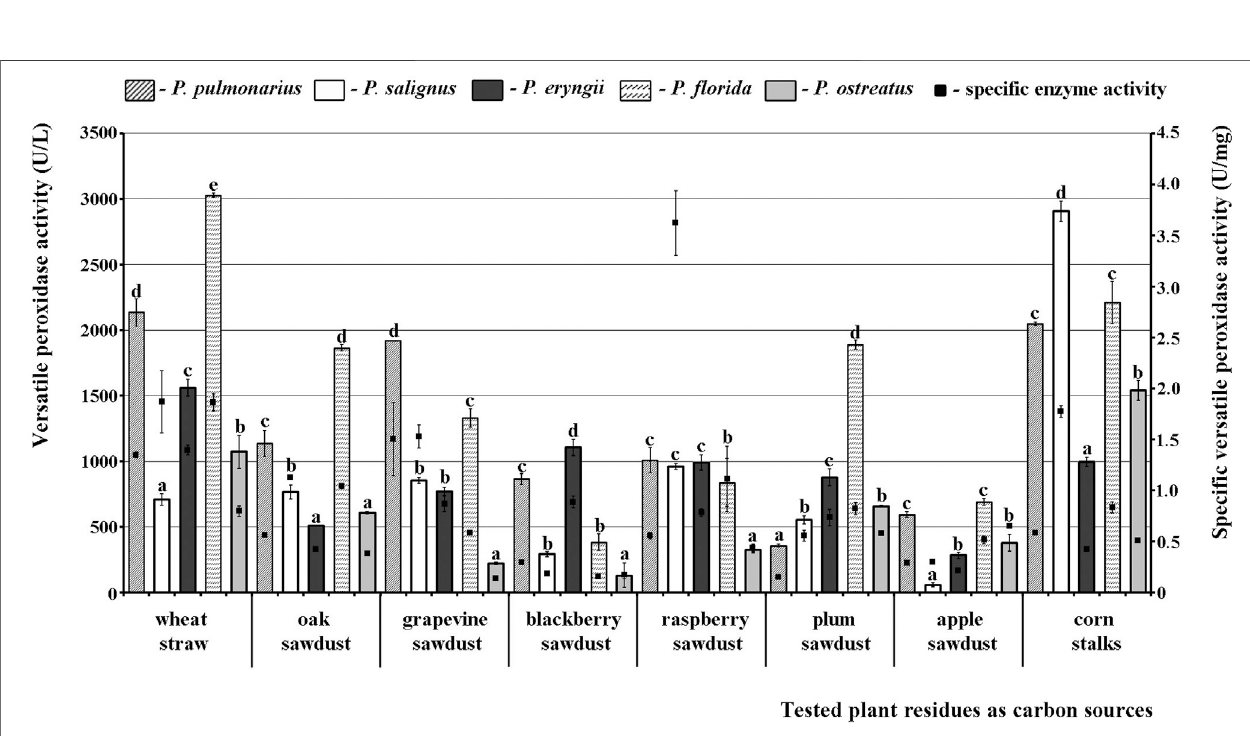
Frontiers in Bioengineering and Biotechnology |